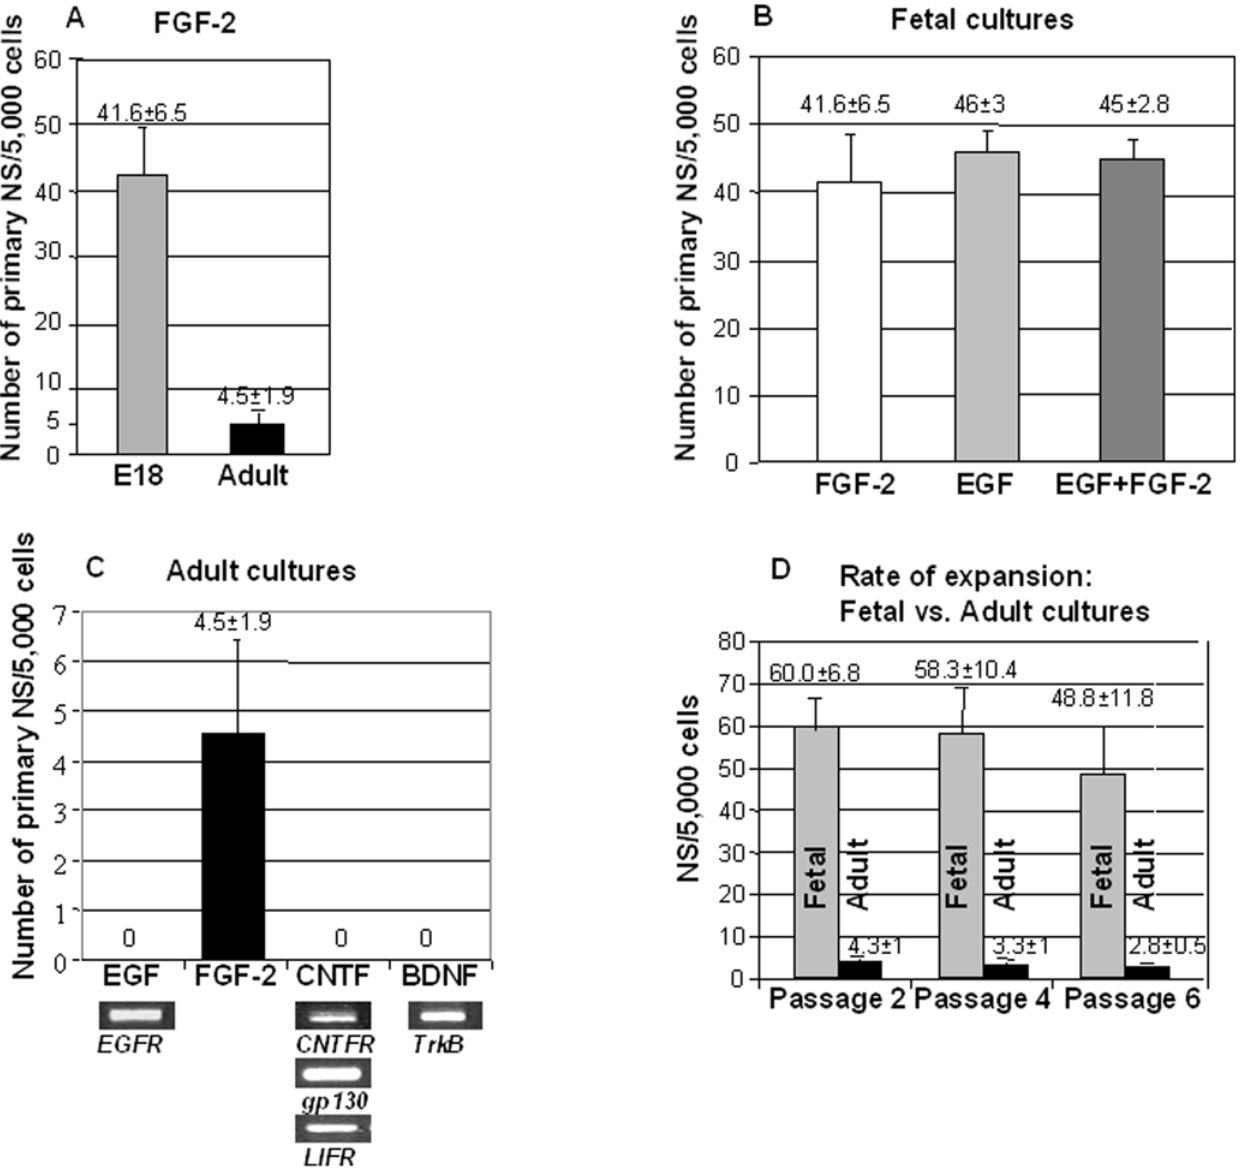
Figure 2. Efficiency of primary NS formation in the presence of different growth factors and rate of expansion of fetal vs. adult NS. A, Comparison of the number of NS formed in either fetal or adult hypothalamic cultures in the presence of FGF-2 after 7DIV. B, Comparison of the numbers of primary NS formed in fetal hypothalamic cultures in the presence of either EGF, FGF-2 or EGF plus FGF-2 after 7DIV. C, Comparison of the numbers of primary NS formed in adult hypothalamic cultures in the presence of either EGF, FGF-2 or EGF plus FGF-2 after 7DIV. The insets underneat this graph show the expression of the growth factor receptors for EGF ( EGFR ), CNTF ( CNTFR/gp130/LIFR ) and BDNF ( TrkB ), as detected by RT-PCR in the RNA prepared from adult hypothalami. D, Comparison of fetal vs. adult NS rate of expansion upon serial passages, all cultures were kept in the presence of FGF-2 plus EGF and counted after 7DIV, respectively before passage 2 (secondary NS), 4 or 6. Values are average number of NS 6 SEM (n=3 or 4 independent